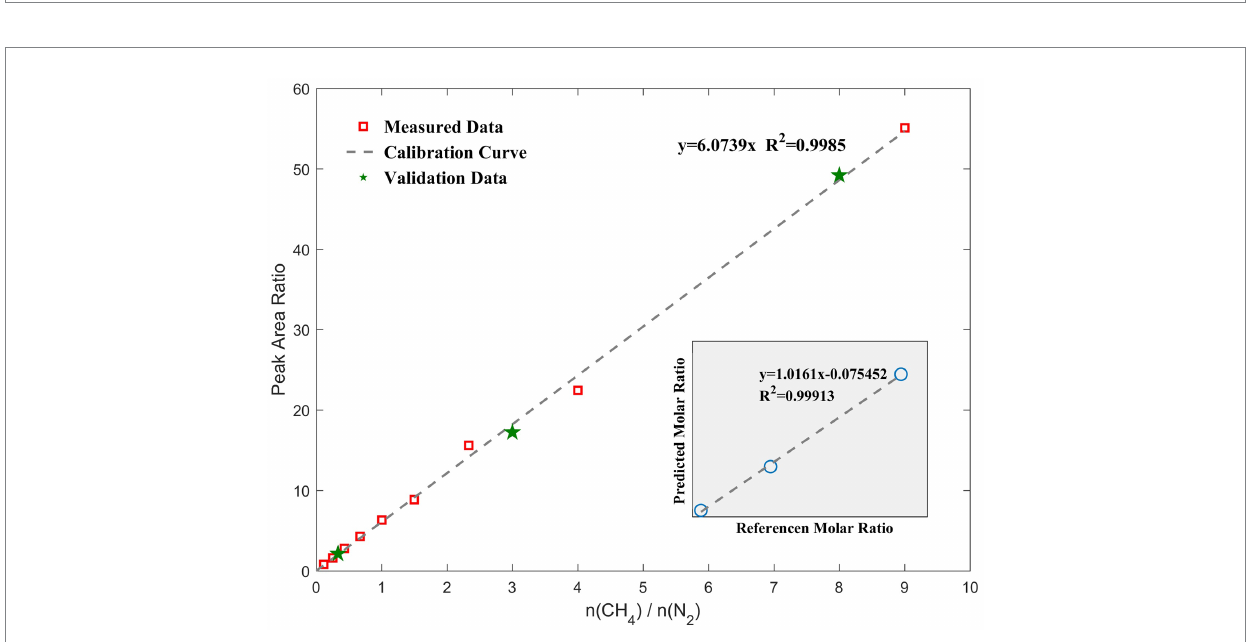
FIGURE 4 Quantitative calibration curve of the molar ratio of the gaseous mixtures to the Raman peak area ratio. Error bars are within the symbol size; therefore, the relevant values are shown in Table 1. The green stars are validation data that are randomly mixed to test the difference between the theoretical and measured values, and they are close to the calibration curve. The lower-right corner shows the molar ratio predicted by the calibration curve versus the actual